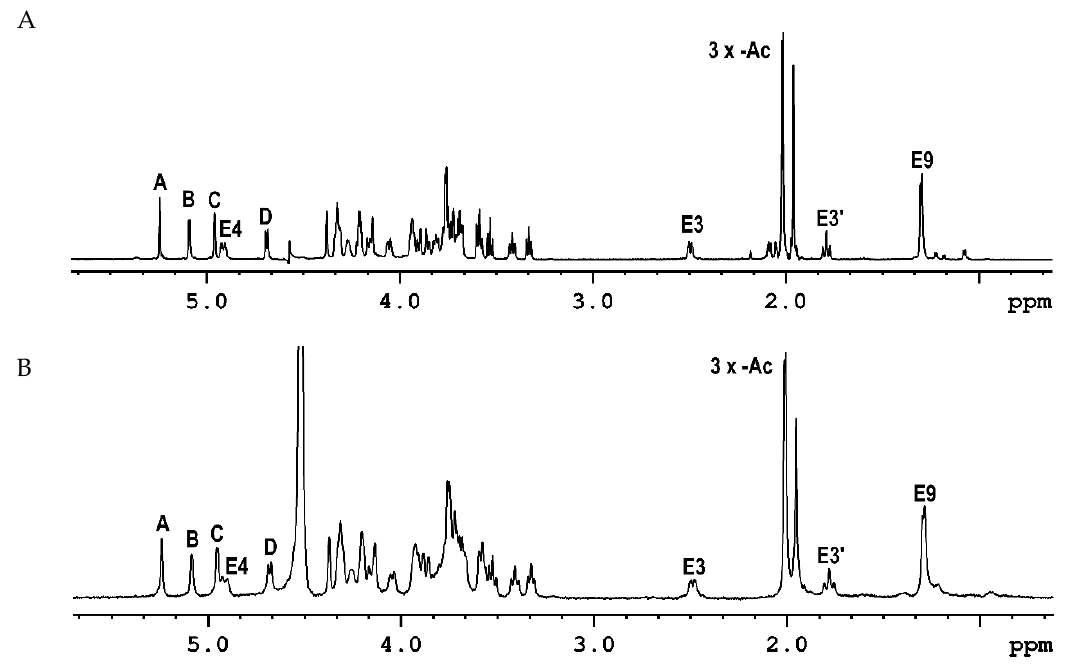
Figure 1. 1 H NMR spectra of the OPS isolated from P. parmentieri SCC3193 ( A ) and P. parmentieri IFB5432 ( B ).